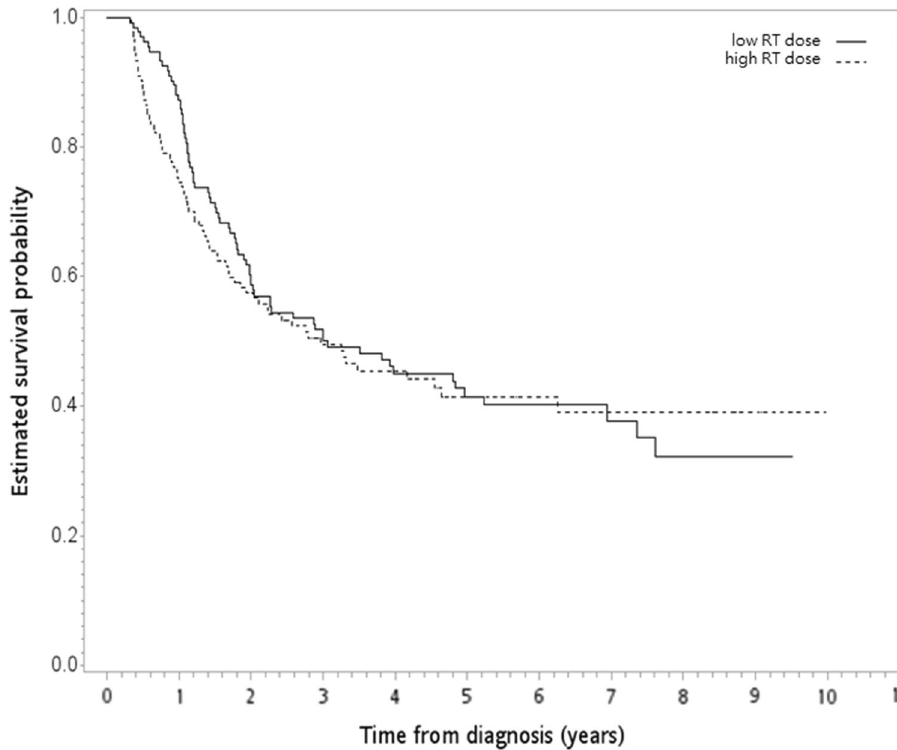
Fig. 4 Kaplan ‒ Meier overall survival curve (in years)